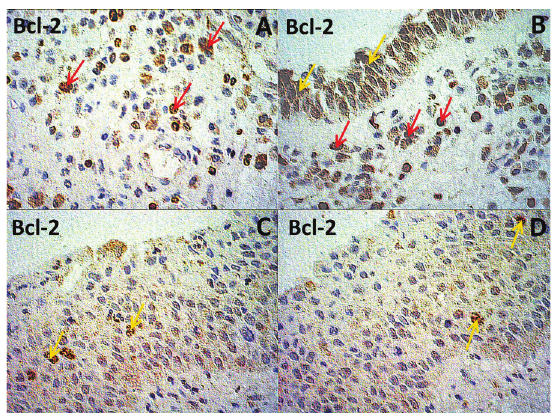
Figure 3 - Immunostaining for Bcl-2 in patients with CRSwNP. The amount of Bcl-2-positive cells in the lamina propria is visually higher than in the control group (A, B; red arrows). Strong Bcl- 2 expression is observed in nasal epithelial cells that cover the polyps (B, C, D; yellow arrows). 400x